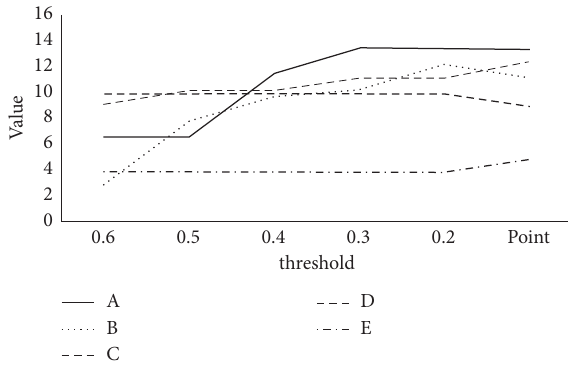
Figure 6: Statistical results of algorithm intelligence evaluation.